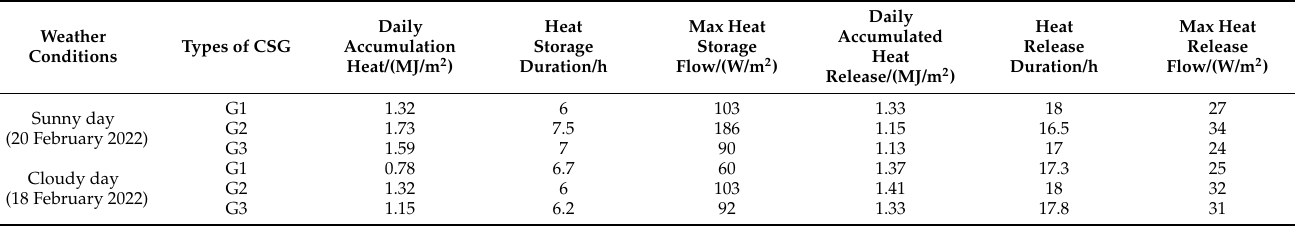
Table 2. Soil heat storage and release performance